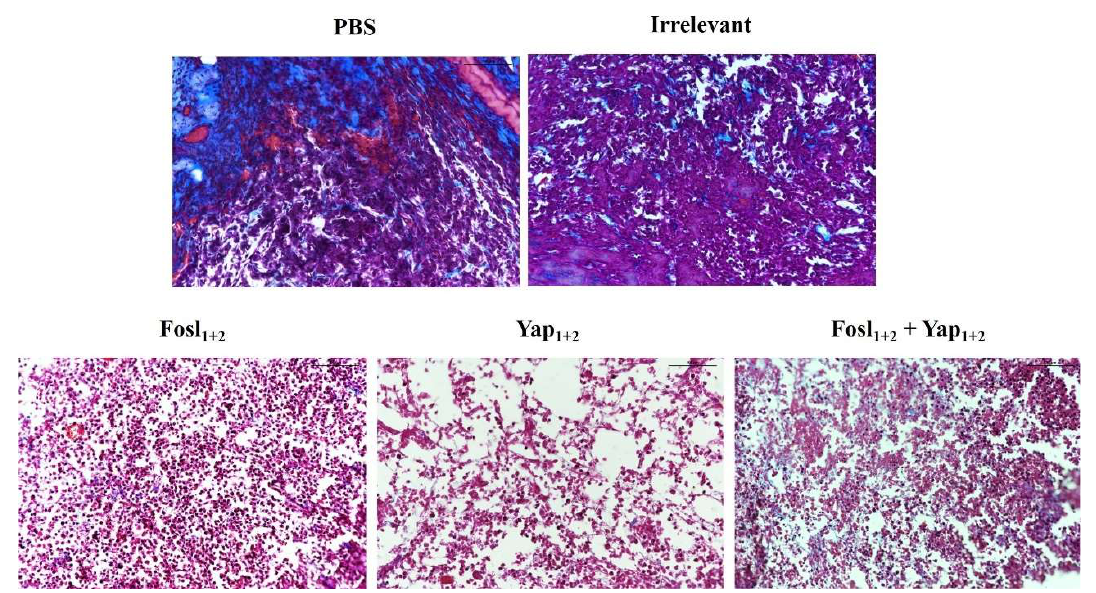
Figure 7. Masson’s trichrome stained paraffin sections of representative mouse tumors for each treatment (PBS, Irrelevant siRNA, Fosl 1+2 , Yap 1+2 and combination of Fosl 1+2 + Yap 1+2 lipoplexes). Staining: blue (collagen), pink-purple (cytoplasm), red (muscle/erythrocytes) and black (cell nucleus). Scale bars: 100 μm. Magnification: 20×.